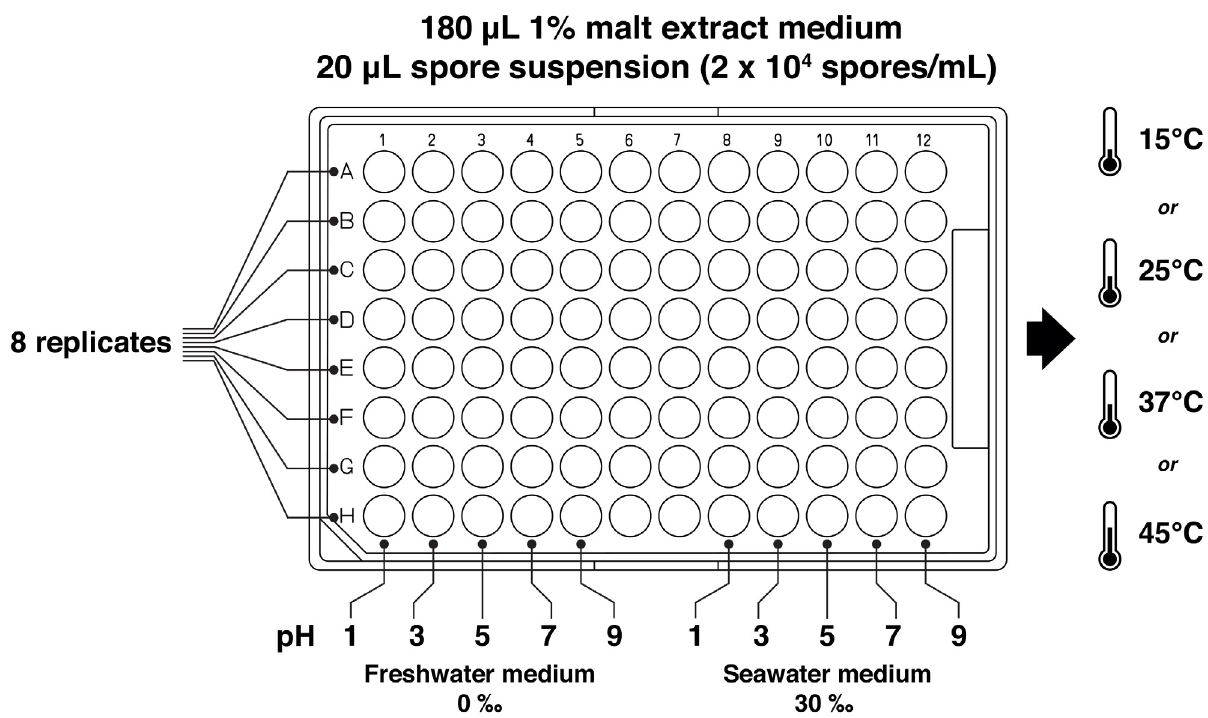
Fig 1. Experimental set-up. Combined effects of temperature (15 ˚C, 25 ˚C, 37 ˚C, 45 ˚C), salinity (0 ‰, 30 ‰) and pH (1, 3, 5, 7, 9) on mycelial growth of fungi were studied using a microtitre plate method.